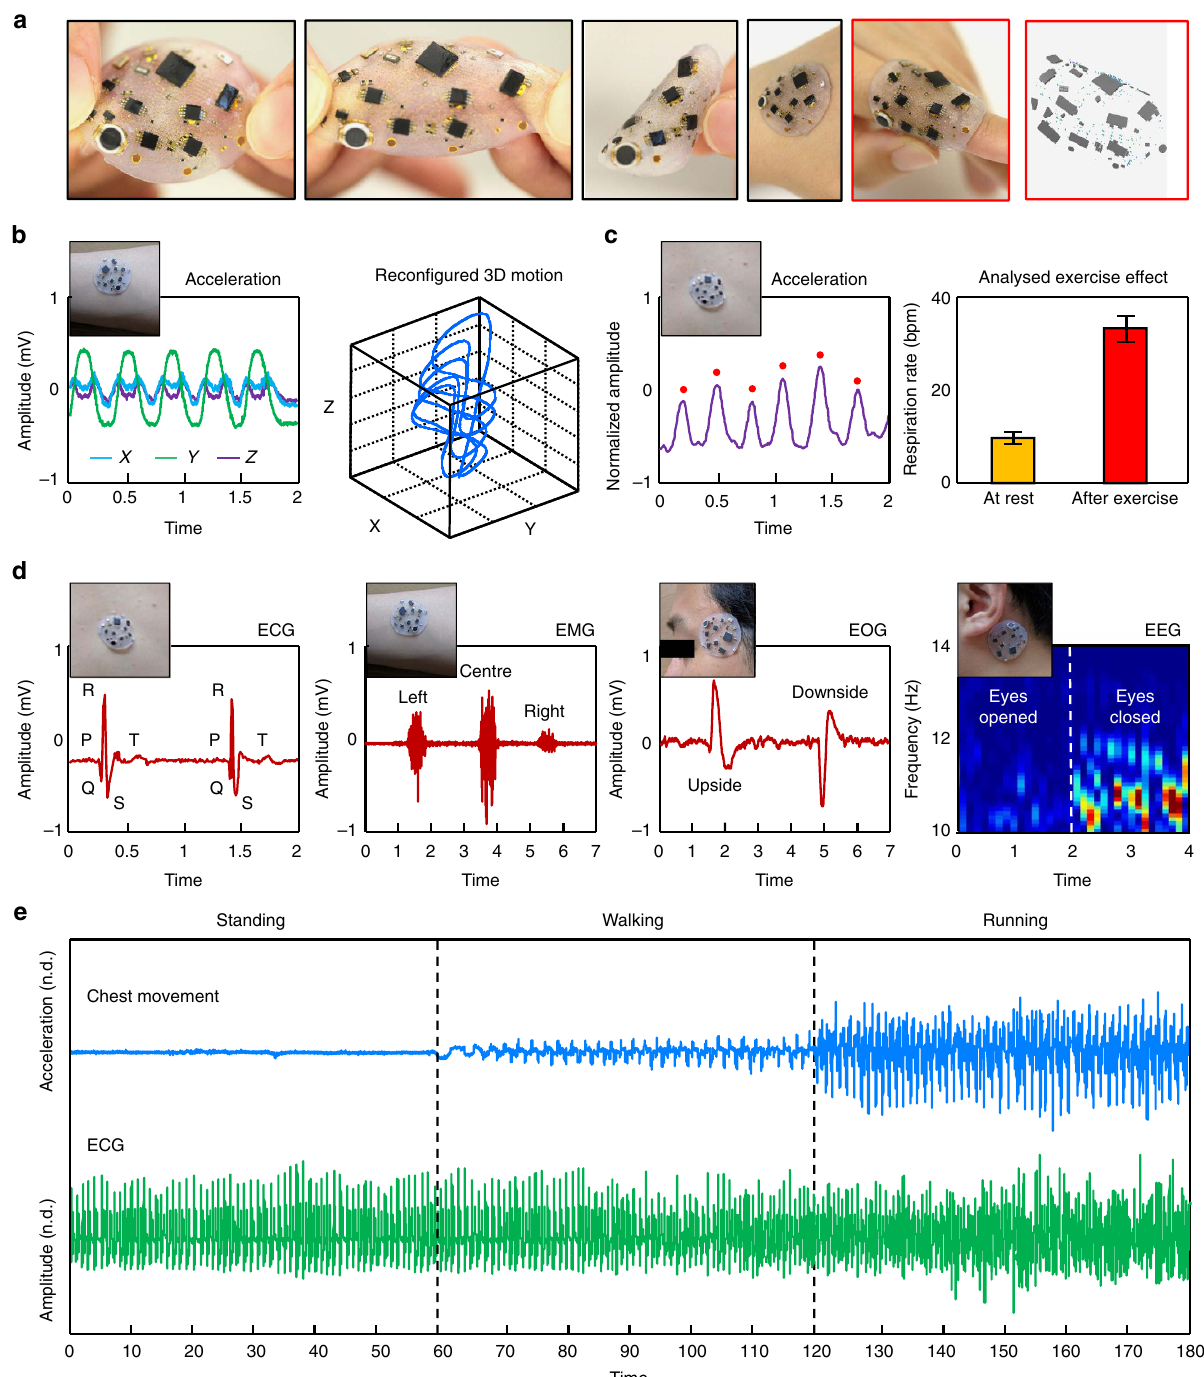
Figure 4 | Mechanical and operational characteristics of the complete and encapsulated system. ( a ) Optical images of a device deformed in different ways, with corresponding FEA results highlighted in red coloured boxes. ( b ) Representative recordings of three-axis acceleration from a device on the left forearm and inferred 3D patterns of motion. ( c ) Results for respiration rate extracted from frequency analysis of accelerometer data from a device placed on the chest, for cases at rest and after physical exercise. ( d ) Electrophysiological recordings with inset images of the device on the skin: electrocardiogram (ECG), electromyogram (EMG), electrooculogram (EOG) and electroencephalogram (EEG). ( e ) Wireless, multimodal monitoring of body activity, through simultaneous measurements of ECG (plotted in green colour) and movements of the chest by accelerometry (plotted in blue colour) during a time interval that includes standing (0–60s), walking (60–120s) and running